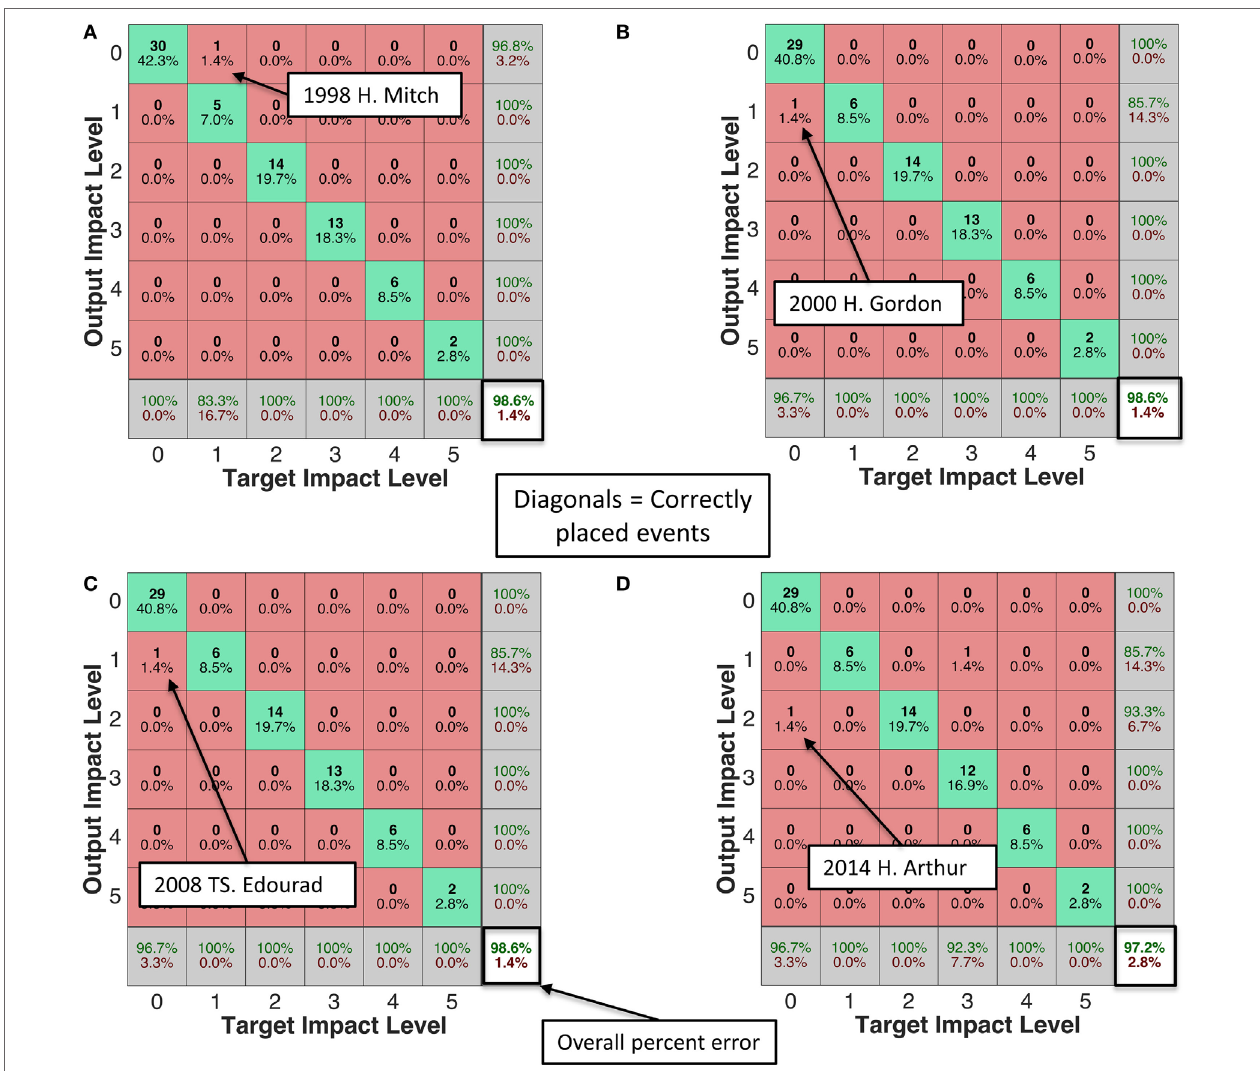
FigUre 4 | Storm event placement in building HIL Models (a) 2016a, (B) 2016b, (c) 2016c, and (D) 2016d (H = hurricane, TS = tropical